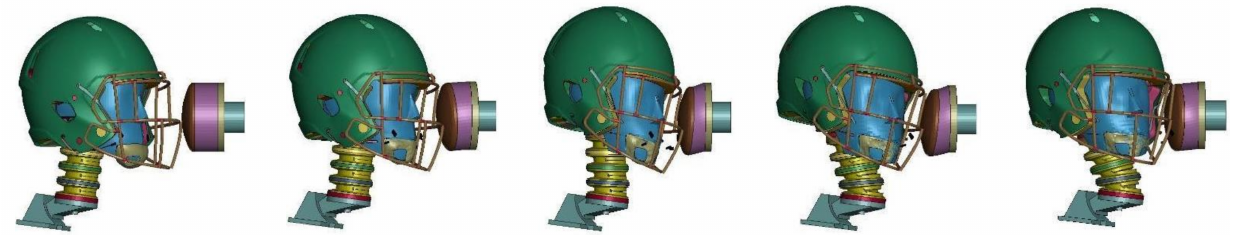
Figure 7. Course of simulation (0–20 ms, 5 ms interval) in configuration A.